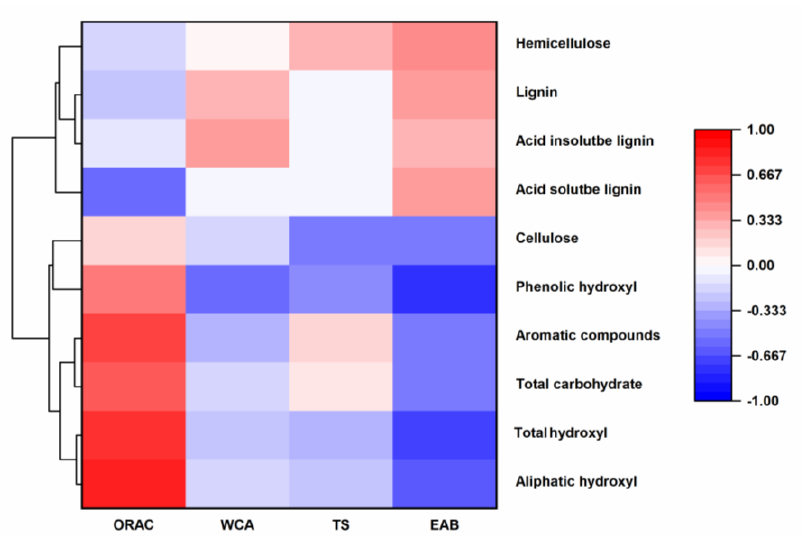
Figure 8. The heatmap combined with the Pearson correlation coefficient among the different factors. Factors including hemicellulose, lignin, acid-soluble lignin, acid insoluble lignin and cellulose from soluble solids; phenolic hydroxyl, total carbohydrate, total hydroxyl and aliphatic hydroxyl by 31P NMR and aromatic compounds by GC − MS were related to the antioxidant properties (ORAC), hydrophobicity (WCA), and mechanical properties (TS and EAB). Different color blocks represent different correlation coefficient values of the corresponding variables, using the color scale as a reference. ORAC (antioxidant activity obtained by measuring ABTS + clearance), WCA (water contact angle), TS (tensile strength), EAB (elongation at break).